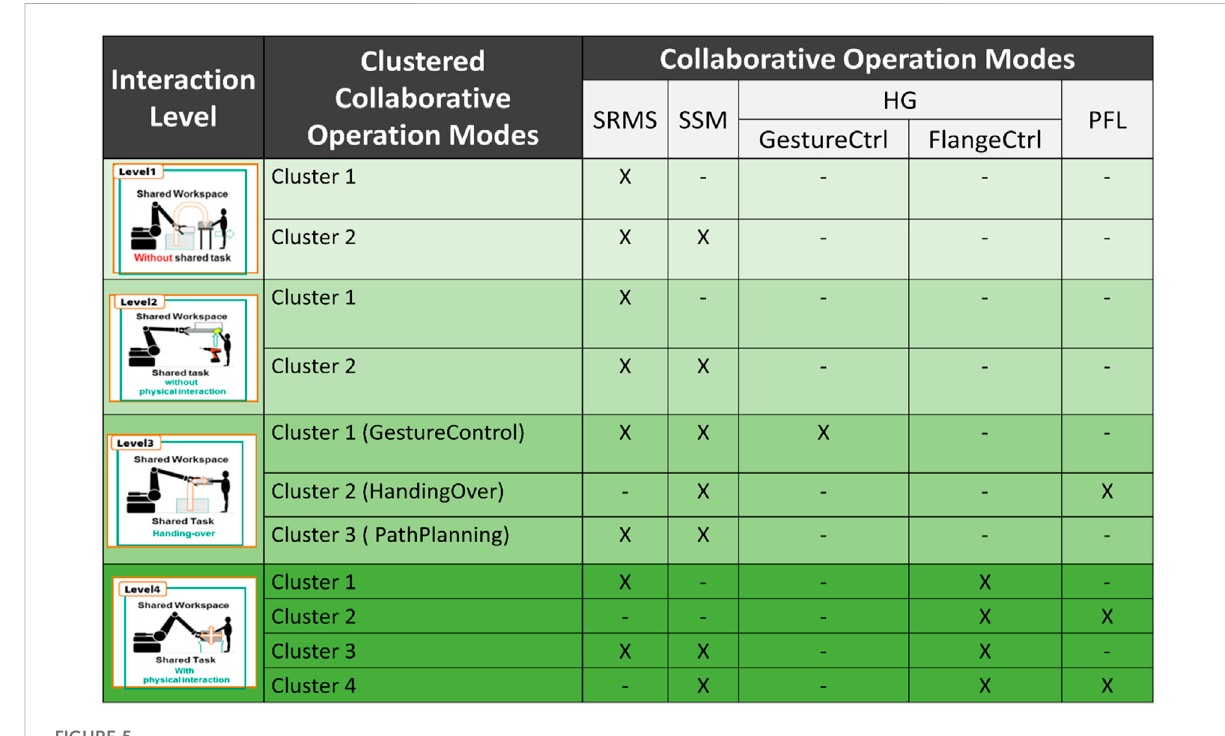
Some possible examples for clustered collaborative operation modes in